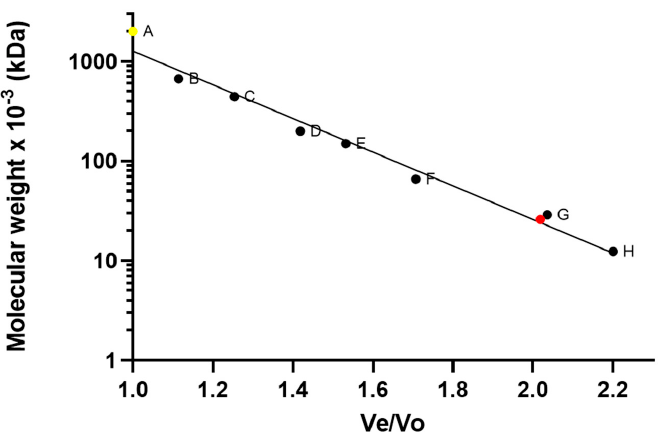
Figure 1. Size-exclusion chromatography of IMAC-purified recombinant human ciliary neurotrophic factor (rhCNTF). Pooled and concentrated eluates from IMAC batch-purification were subjected to SEC in a Superdex 200 prep grade packed C16/40 column with 100 mM NaH2PO4, 300 mM NaCl, pH 8.0, 1 mM DTT as the running buffer with a flow rate of 0.5 mL/min. The column was calibrated with blue dextran (A; 2,000 kDa), thyroglobulin (B; 669 kDa), apoferritin (C; 443 kDa), β -amylase (D; 200 kDa), alcohol dehydrogenase (E; 150 kDa), bovine serum albumin (F; 66 kDa), carbonic anhydrase (G; 29 kDa), and cytochrome c (H; 12.4 kDa). rhCNTF eluted at 56 mL (shown in red), with an estimated molecular weight of 26 kDa.